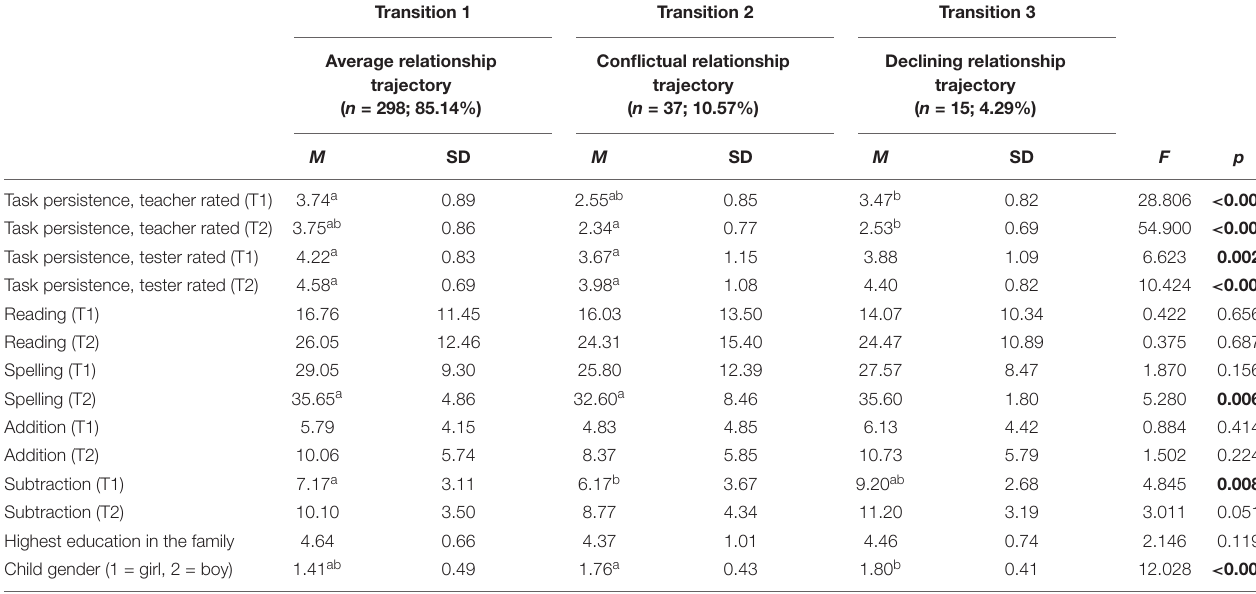
TABLE 7 | Mean differences in latent transitions regarding children’s task persistence and performance.